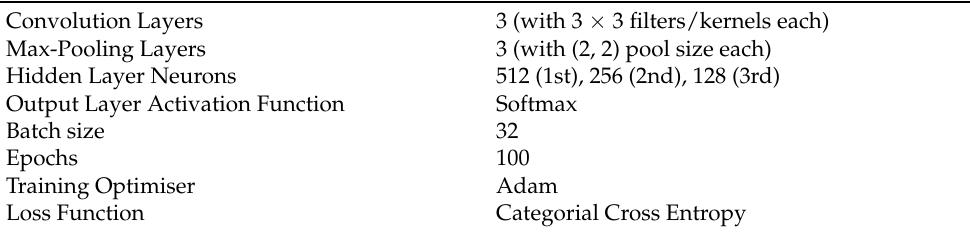
Table 5. The proposed PDDCNN model configuration details of various